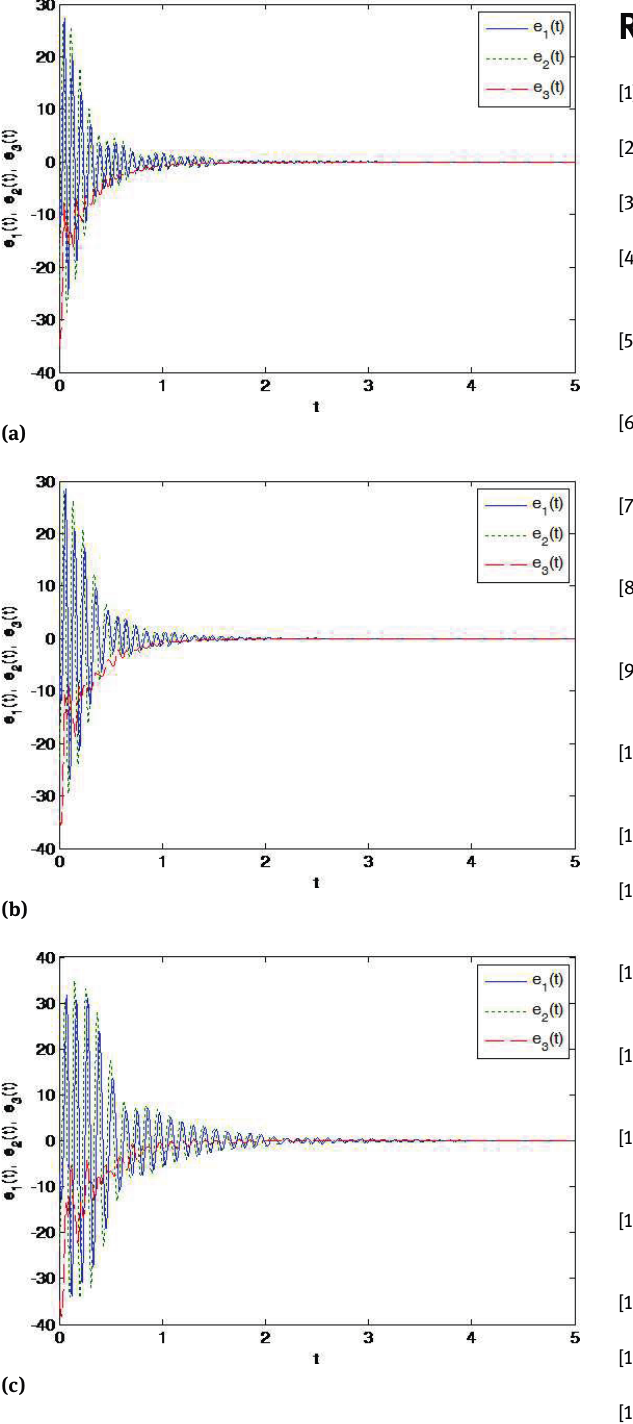
Fig. 6: The evolution of the error functions e 1 ( t ), e 2 ( t ) and e 3 ( t ) : (a) q = 0.92 , (b) q = 0.96 , (c) q = 1 , using backstepping method.